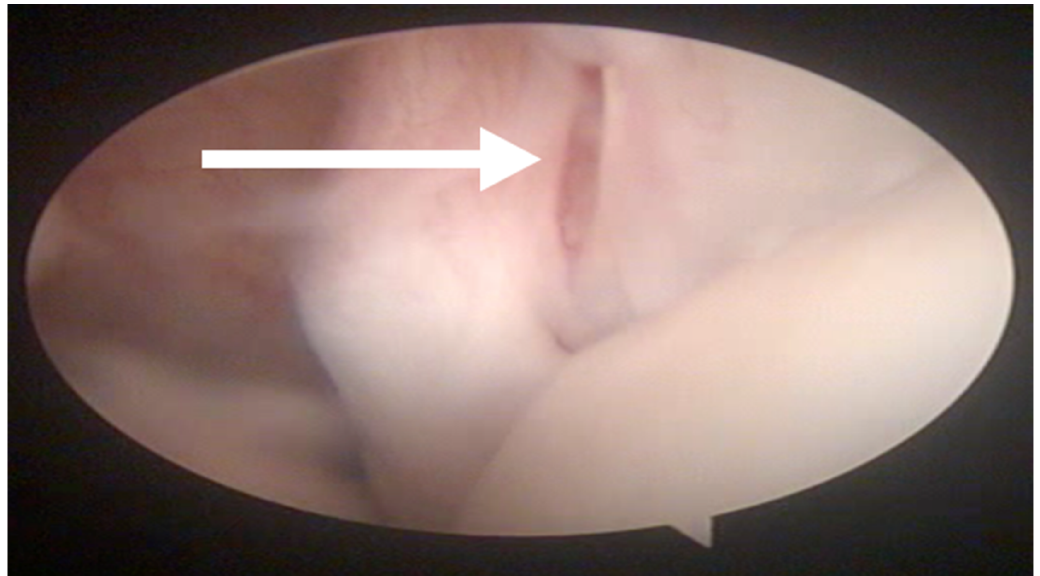
Figure 2. Arthroscopic evaluation of the tendon of the sub-scapularis muscle. A partial rupture is indicated by the white arrow.